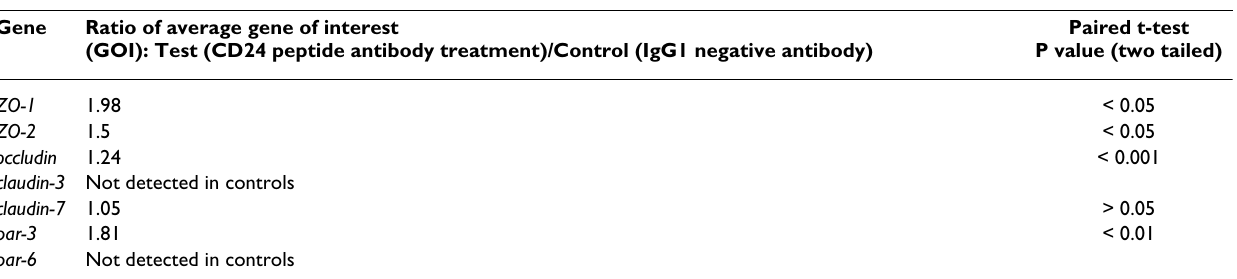
Table 1: Real-time quantitative RT-PCR analysis of changes in expression of genes encoding tight junction proteins in response to anti- CD24 peptide antibody Gene Ratio of average gene of interest (GOI): Test (CD24 peptide antibody treatment)/Control (IgG1 negative antibody)